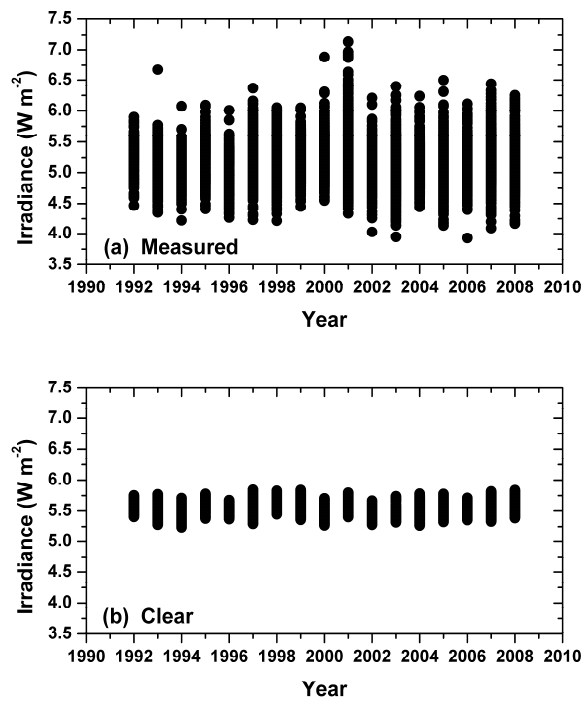
Fig. 1. The irradiance dataset for the wavelength band 320–340nm covering 17 solstice periods, 1992–2008: (a) Measured values. (b) Computed clear-sky